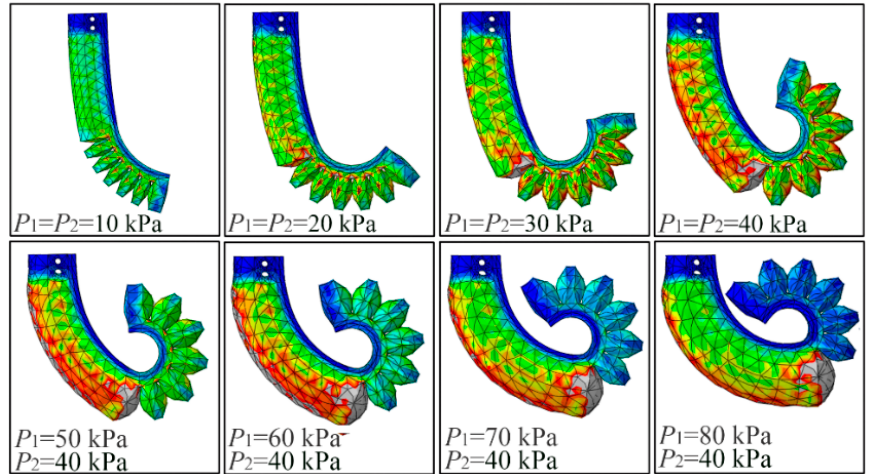
Figure 8. Bending deformation of the proposed soft actuator under different pressures.